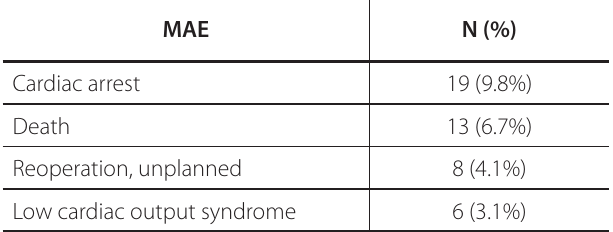
Table 2 . Major adverse events (MAE) observed within 48 hours after